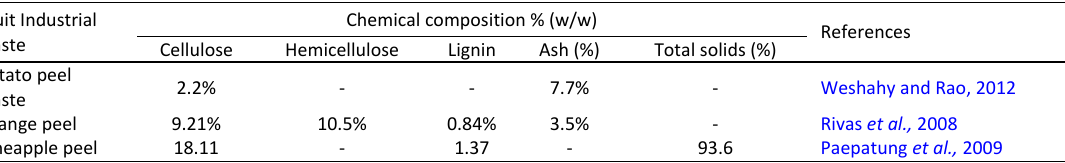
Table 3: Fruit industrial waste chemical composition